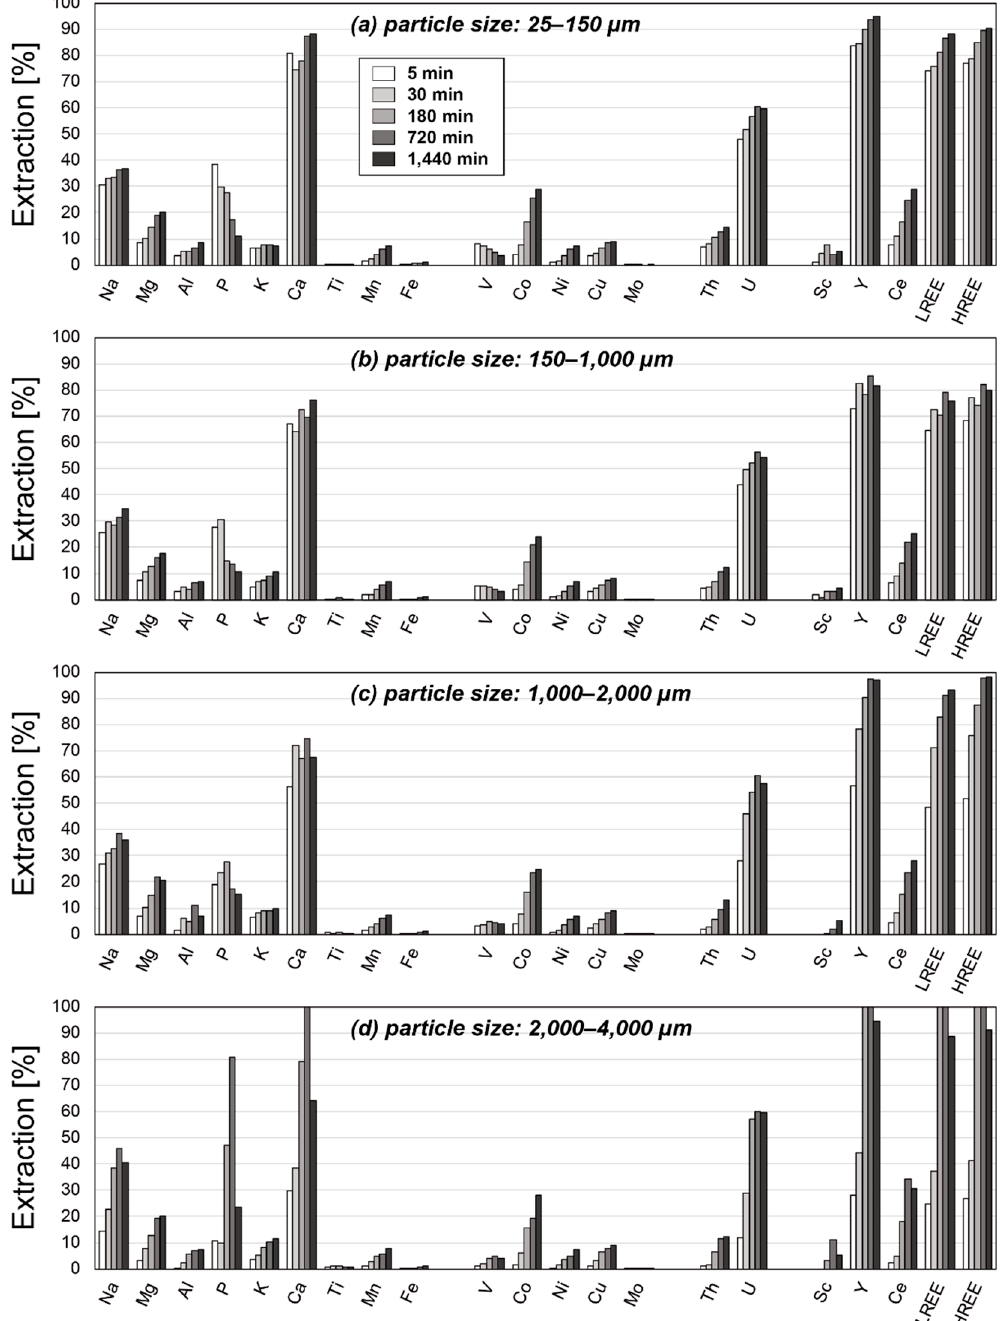
Figure 7. Extraction percentages of major elements, valuable metals, radioactive elements, and REE from the Cyprus umber as a function of time using hydrochloric acid as a leachate. Experiments with the particle size of ( a ) 25–150 μ m, ( b ) 150–1000 μ m, ( c ) 1000–2000 μ m, and ( d ) 2000–4000 μ m.